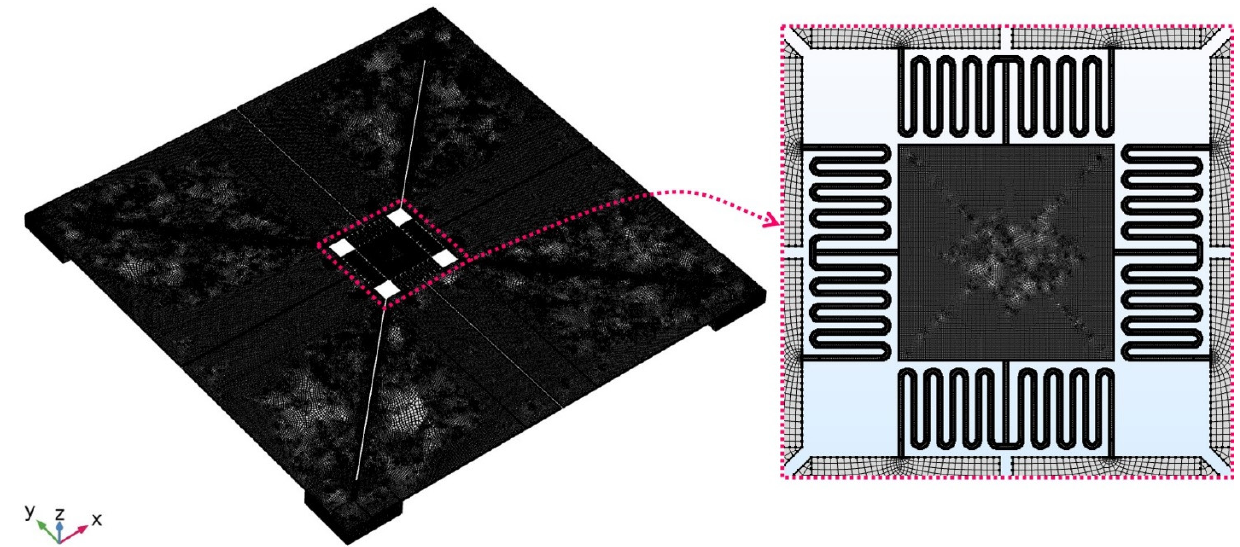
Figure 4. Meshing of the entire geometry of the proposed device.